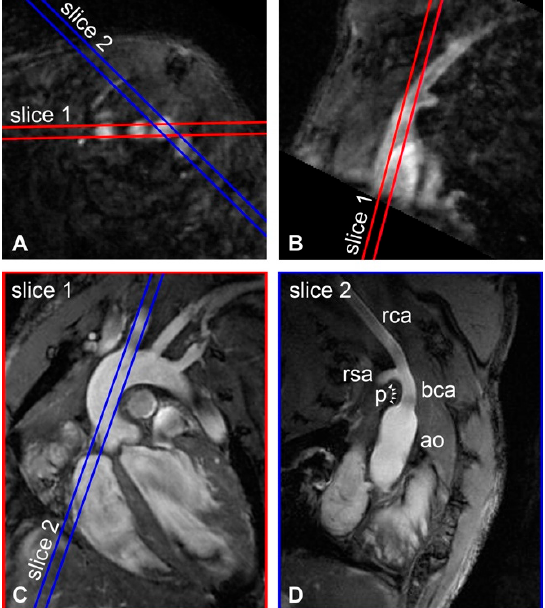
Figure 1. Slice planning. ( A ) Axial oblique and ( B ) sagittal oblique slices reconstructed from 3D-TOF-FLASH were used for planning T 1 -weighted anatomical reference images with ( C ) aortic arch view and ( D ) brachiocephalic artery (BCA) view. ao = ascending aorta; bca = BCA; rca = right carotid artery; rsa = right subclavian artery; p = atherosclerotic plaque (arrowheads).